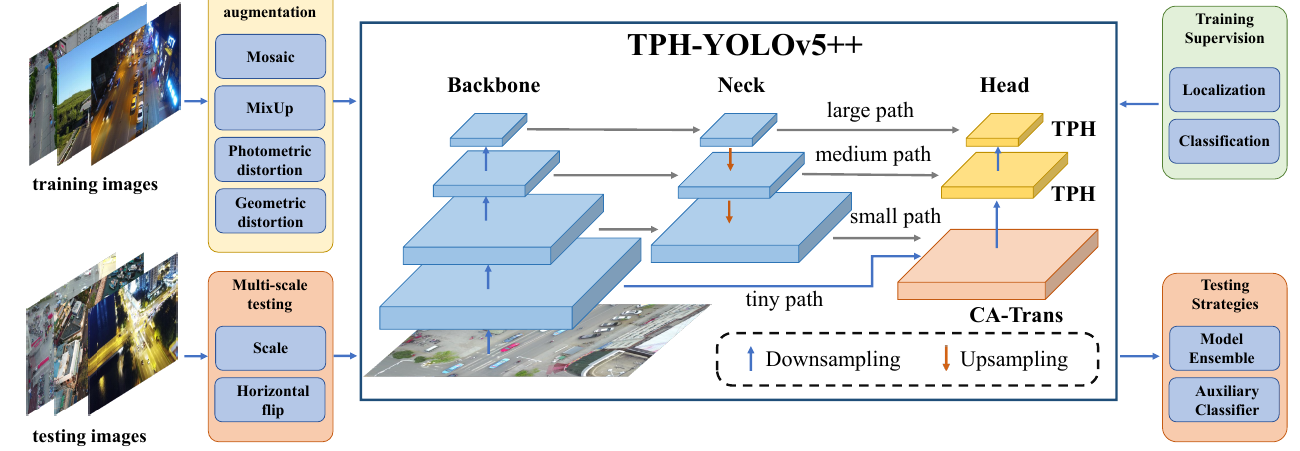
Figure 2. Overview of the working pipeline using TPH-YOLOv5++. Compared to the original YOLOv5, our TPH-YOLOv5 proposes an addition prediction head, four transformer prediction heads (TPH), and tricks to improve detection performance. Based on TPH-YOLOv5, TPH-YOLOv5++ designs a cross-layer asymmetric transformer (CA-Trans) to replace the tiny object detection head and transfer knowledge to the small object detection